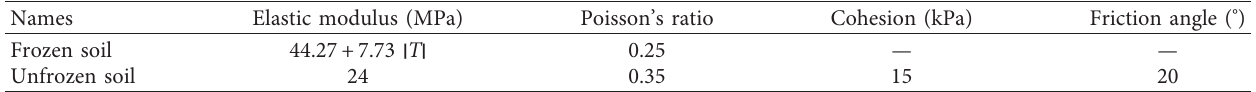
Table 3: Mechanics